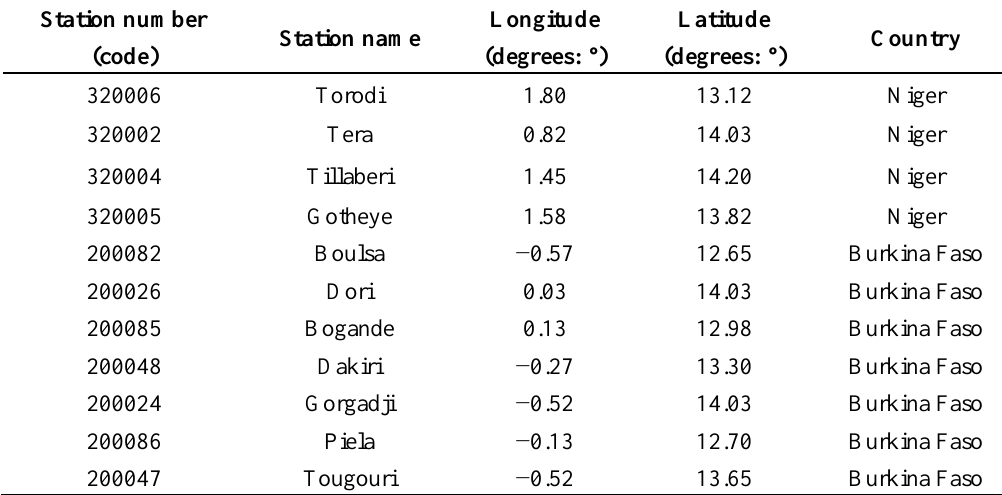
Table 1. Specifics of rainfall